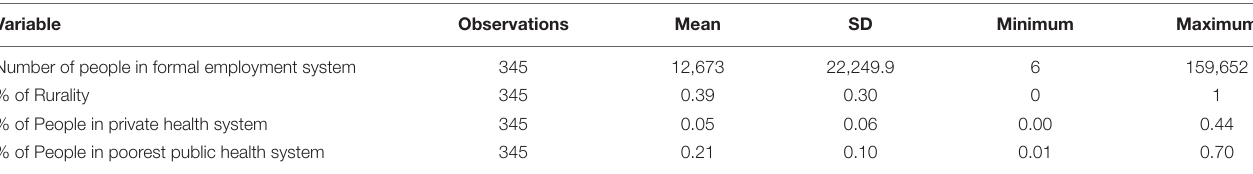
TABLE 1 | Descriptive statistics of auxiliary